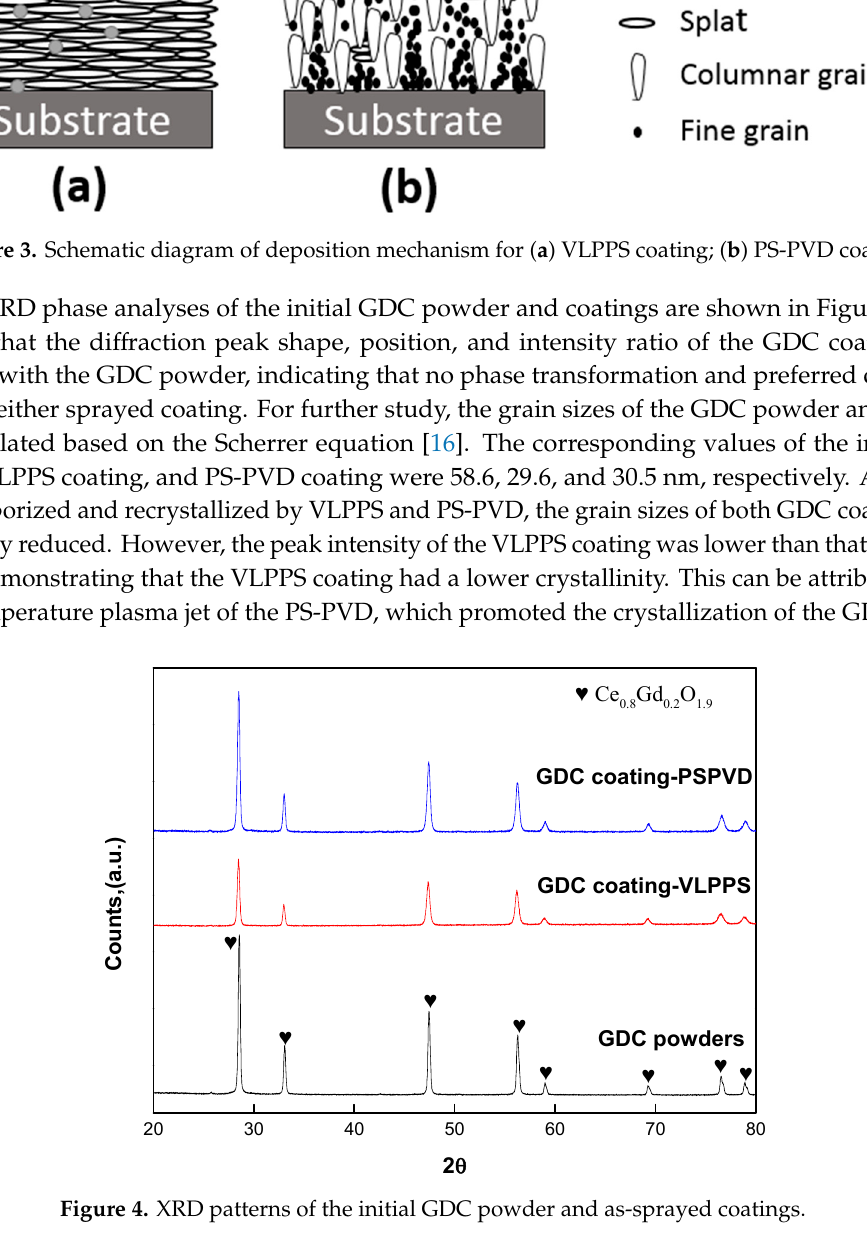
H E Figure 5. The mechanical properties of the as-sprayed GDC coatings and the reference GDC coating. 4. Conclusions To summarize, an agglomerated GDC powder was prepared by spray drying, with an average particle size of 9.63 μ m. Using the agglomerated powder, two GDC coatings were manufactured via VLPPS and PS-PVD. Although the morphologies of both coatings were dense, the deposition mechanisms of the two coatings were significantly different. The VLPPS coating was mainly formed by densely packed molten particles, while the PS-PVD coating was deposited by a mixed vapor